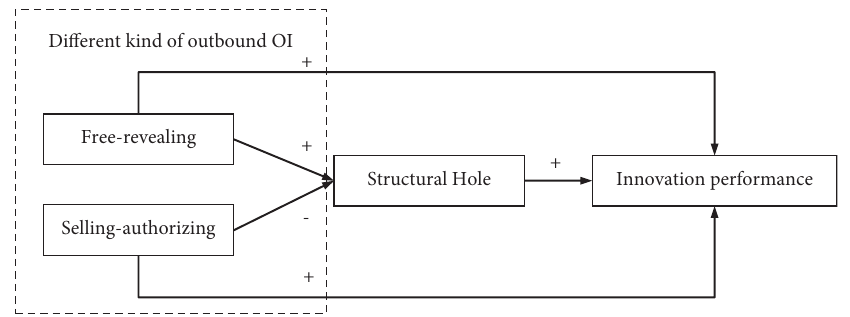
Figure 1: Te hypothetical